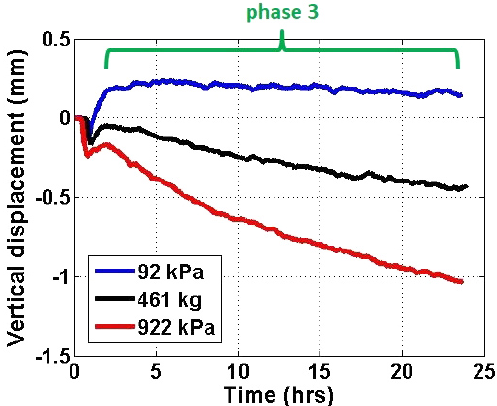
Figure 8. Vertical displacement versus time for a sand sample mea- sured in the ring shear apparatus. After the previously described phases 1 and 2 of vertical displacement, the specimen shows a third phase of behavior: a return to negative vertical displacement. The magnitude is governed by the normal stress. Also, the intensity of dilation in phase 2 seemed to be restricted by the normal